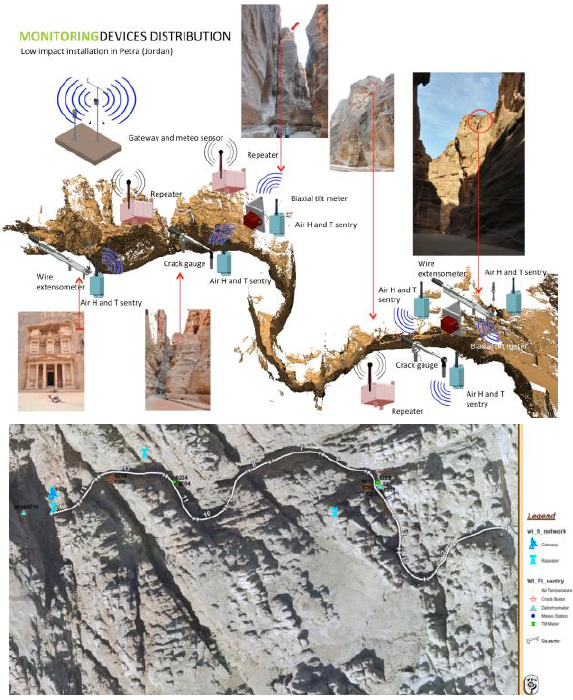
Figure 3. Distribution of the wireless monitoring devices